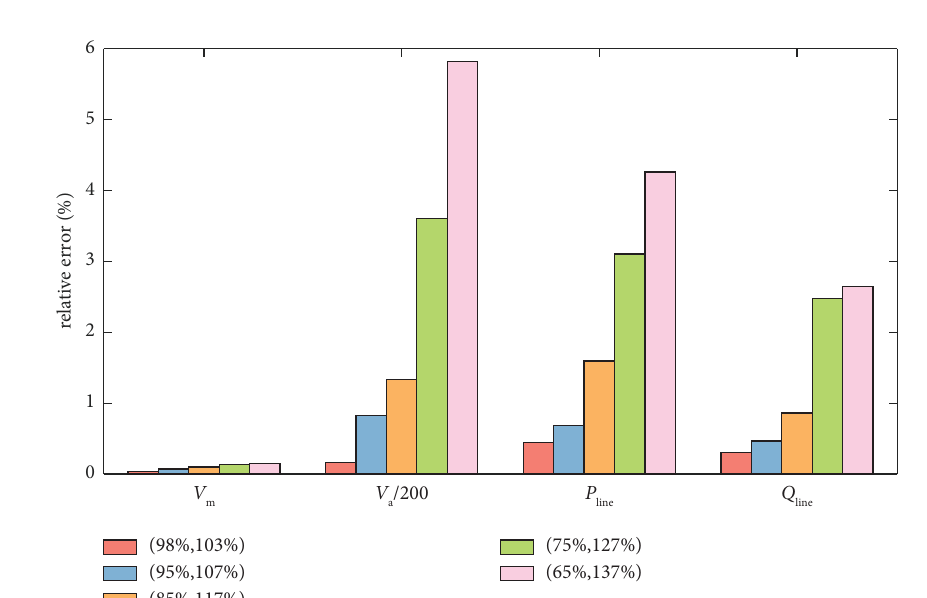
Figure 6: Te mean value of X